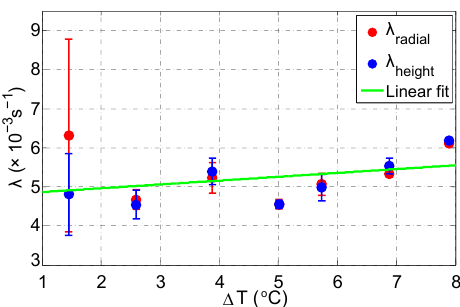
Figure 9. Air reheating rates ( λ ) following an adiabatic pressure reduction versus the initial temperature